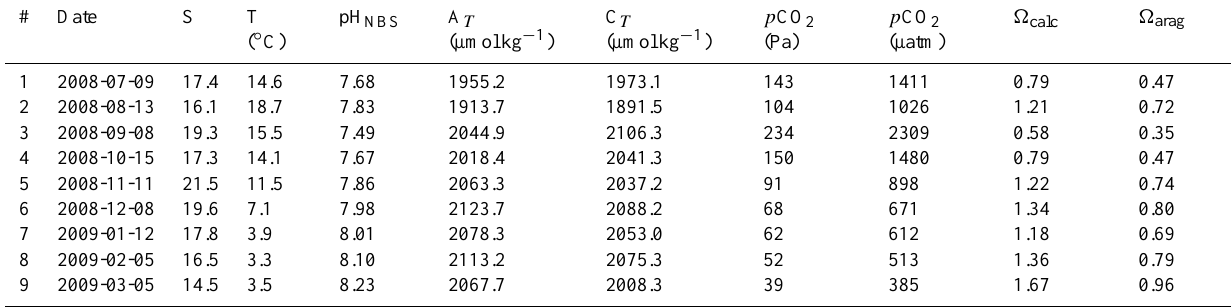
Table 1. Kiel Fjord surface seawater carbonate system speciation 2008 to 2009. See Fig. 1a for corresponding surface pH NBS